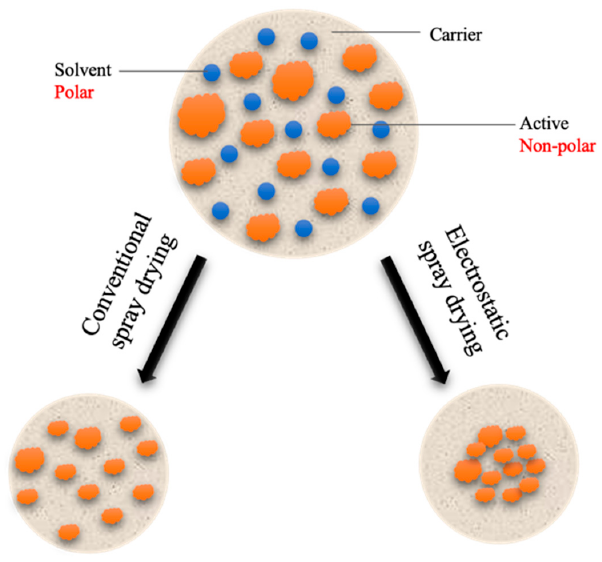
Figure 6. Differences in mechanism of conventional ( left ) and electrostatic ( right ) spray drying